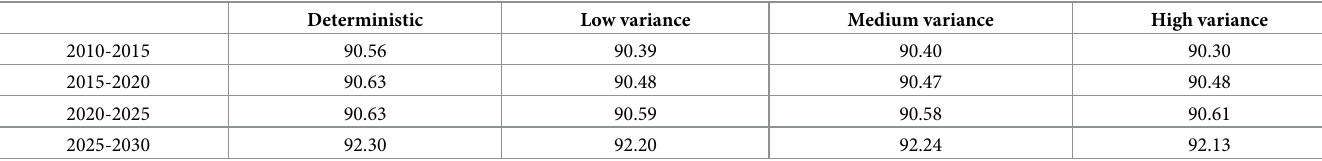
Table 6. Coverage under different scenarios of